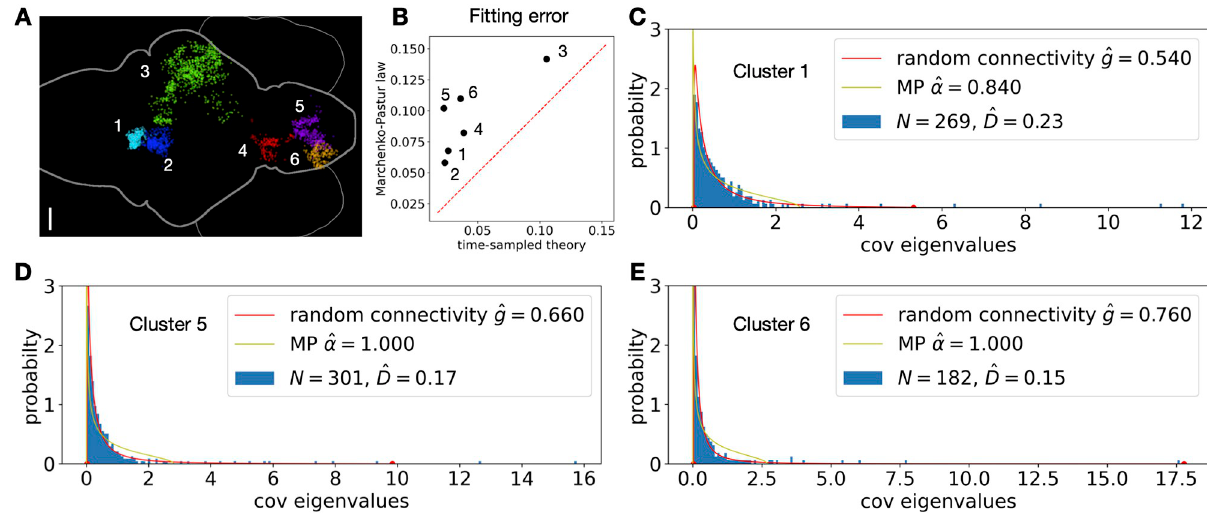
Fig 8. Fitting the theoretical spectrum to data. A . The anatomical map of neurons (dots) in the example functional clusters (different colors) across a larval zebrafish brain (scale bar is 50 μ m, see text and [52]). B . Comparing the fitting error of the time-sampled random connectivity theory (Section 3.7) and the Marchenko–Pastur law. The errors are measured by Eq (38). The red dashed line is the diagonal. ^ D ¼ D = N labeled on each plot is the relative dimensionality (Eq 4). The calcium activity is recorded at a frame rate of 2 Hz and a total of 600 frames of spontaneous activity [52] are used in here. See more details in Methods. Fitting results for all other clusters are in Fig O in S1 Text.